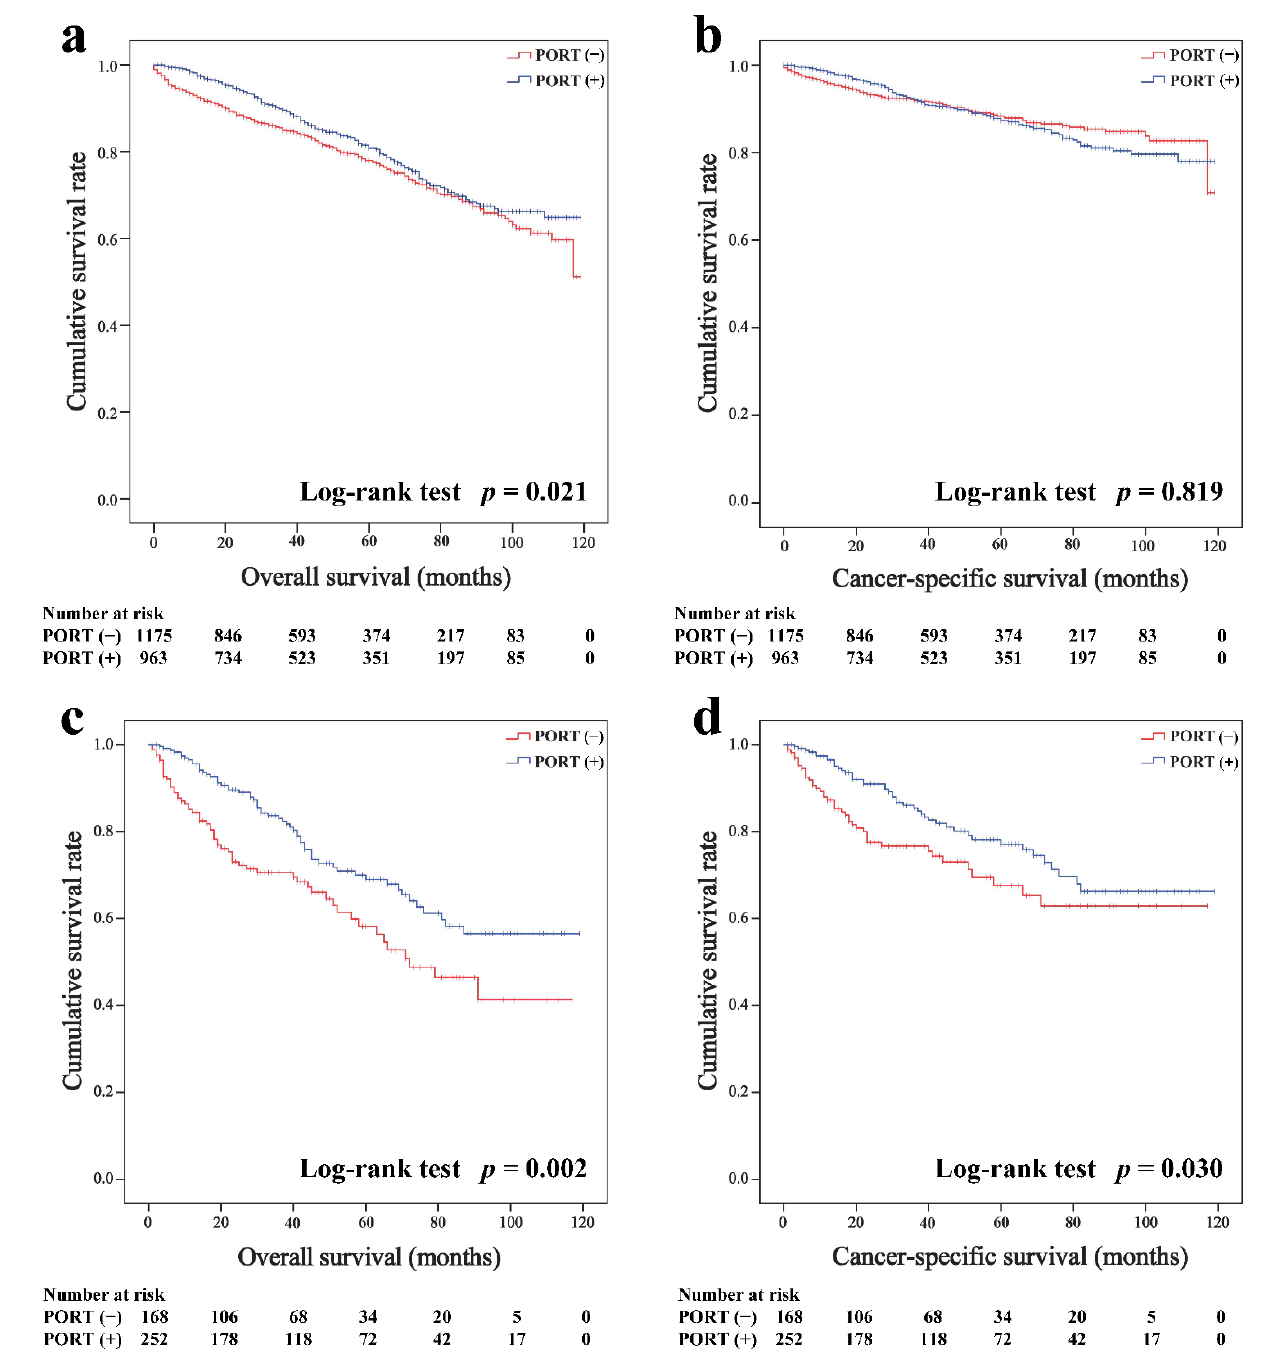
Figure 1. Overall and cancer-specific survival in patients with thymoma ( a , b ) and thymic carcinoma ( c , d ) before matched.